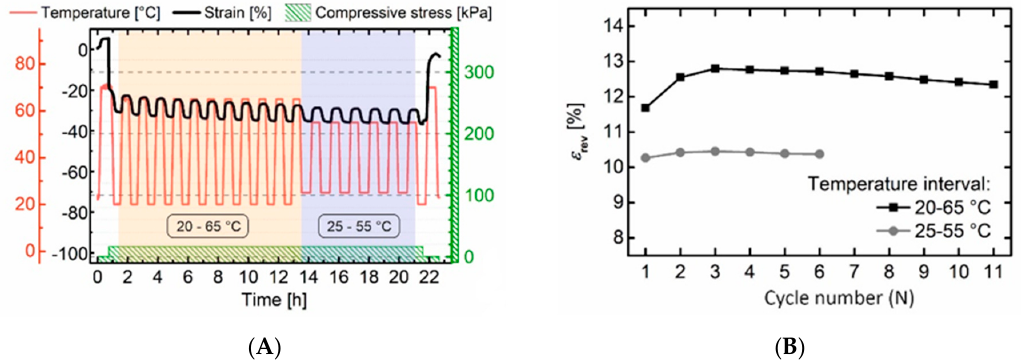
Figure 10. Thermomechanical protocol investigating the influence of T high and T low upon actuation of PEUU foam under constant load conditions in a multiple cycle experiment: Stress-strain-temperature protocol ( A ) and evolution of the associated actuation ( B ).